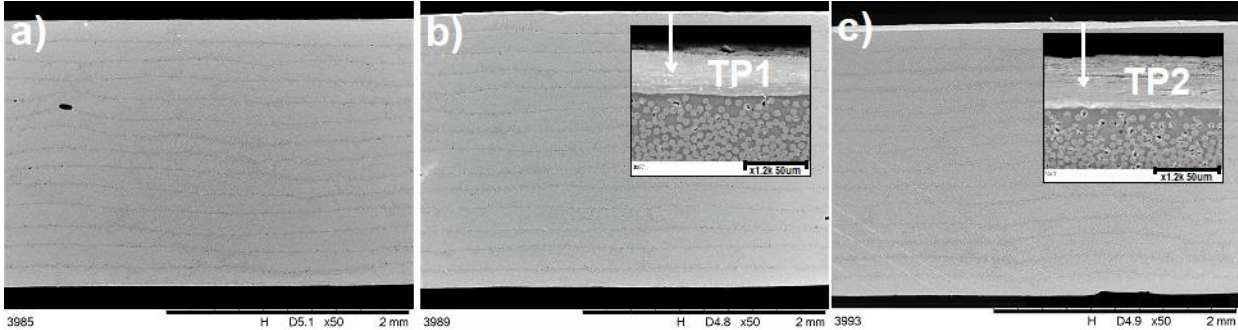
Figure 7. Microstructure of laminates cross-section: ( a ) L1, ( b ) L2, ( c ) L3. Arrows show the layer of Tuball paper. Microstructure observations of the compatibility between Tuball paper and